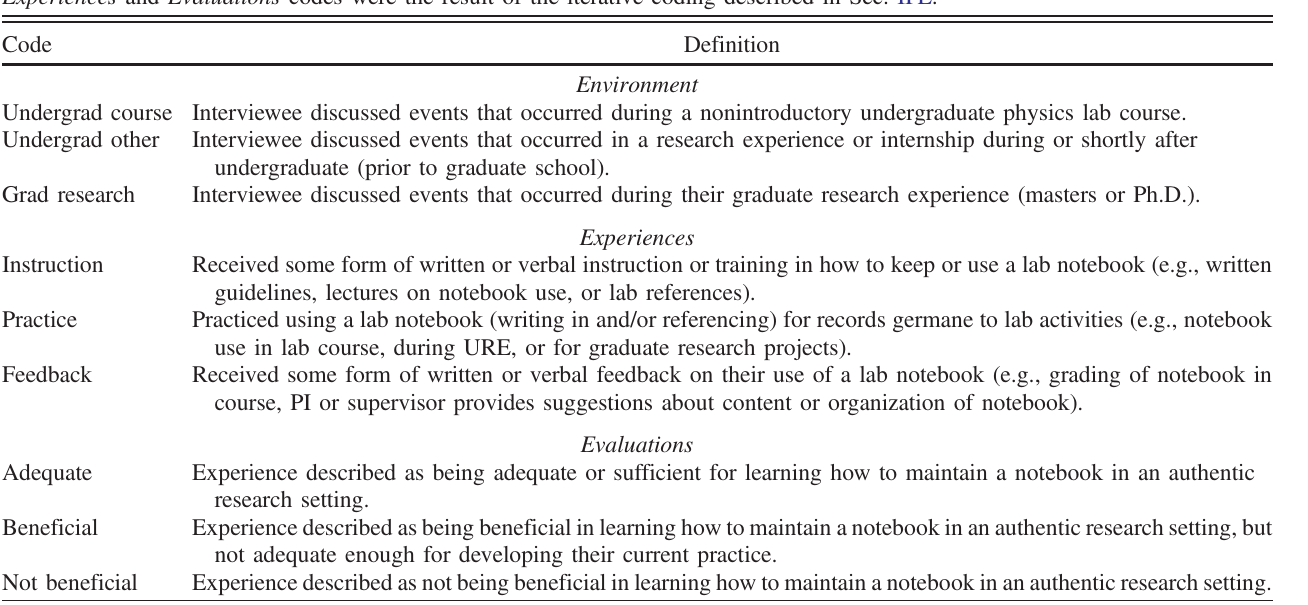
TABLE I. Code scheme used for the third stage of the interview coding. The Environment codes were a priori , where as the Experiences and Evaluations codes were the result of the iterative coding described in Sec. II